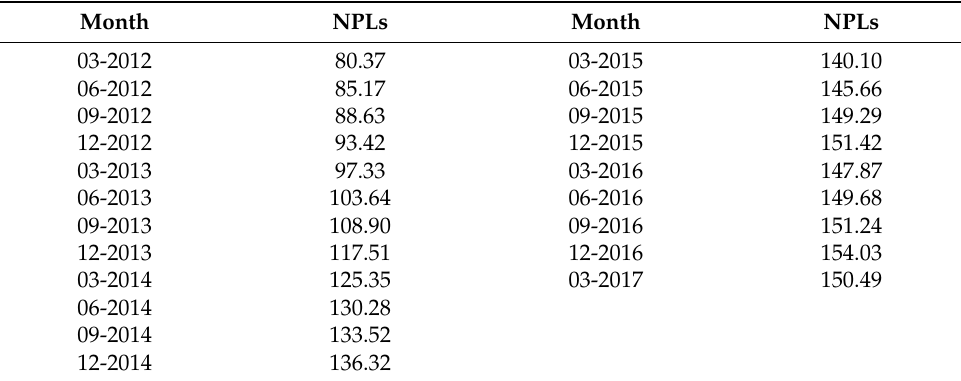
Table 4. Net non-performing loans in Italy, in billions of euros (March 2012–March 2017).